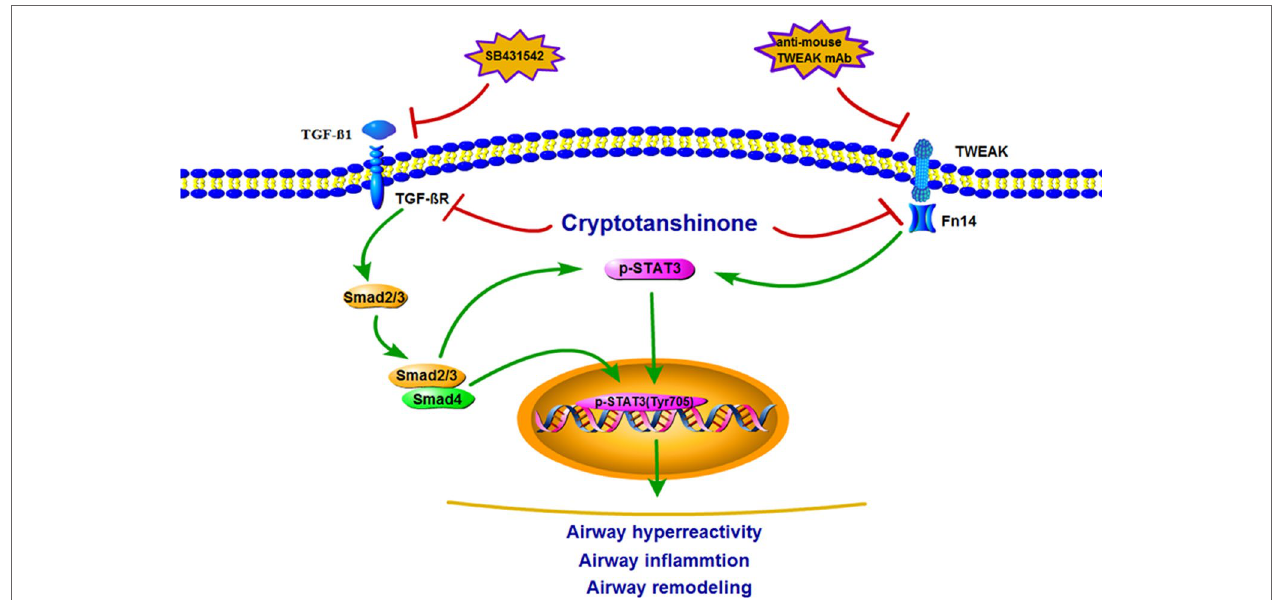
FIGURe 10 | Schematic illustration of the possible molecular mechanism of tumor necrosis factor-like weak inducer of apoptosis (TWEAK)-mediated or transforming growth factor beta 1 (TGF-β1)-mediated airway smooth muscle cells (ASMCs) pro-inflammatory cytokine secretion. TWEAK/Fn14 or TGF-β1/Smad stimulated STAT3 signaling pathways activation in ASMCs, subsequently leading to pro-inflammatory cytokine secretion.